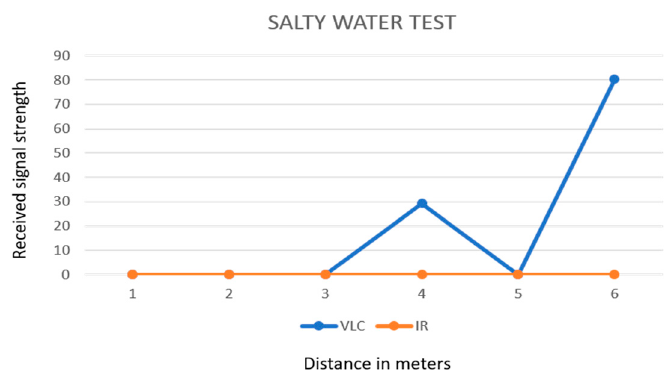
Figure 15 . Salty water test using large water tank.